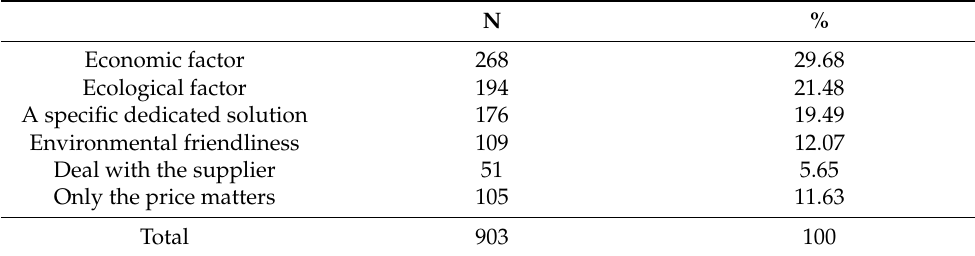
Table 3. Factors influencing the choice of IT investment.